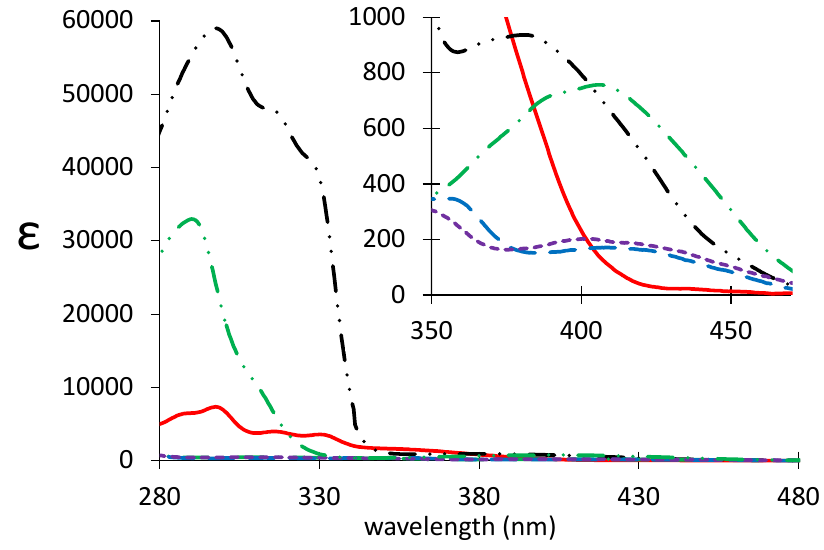
Figure 2. Absorption and long wavelength expansion (inset) of pyridones 10a , b in ethanol and azafluorenones 11a – c in EtOAc. 11c (Cl), —— ; 11b (Ph), — . . — ; 11a (MeO), — . — ; pyridone 10a (H), — — ; 10b (F), – – – .